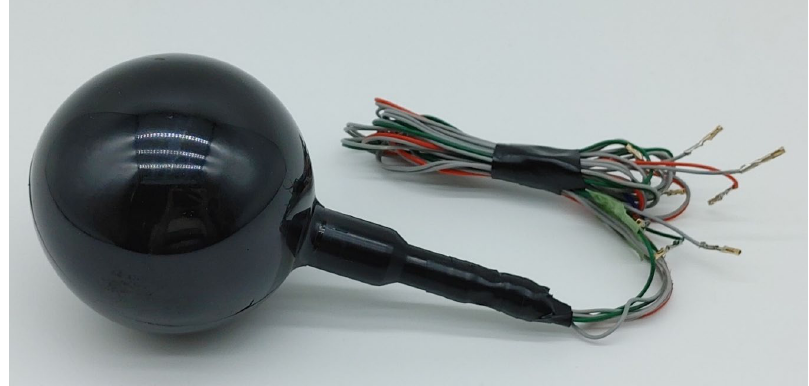
Figure 5. The molded three-dimensional hydrophone.